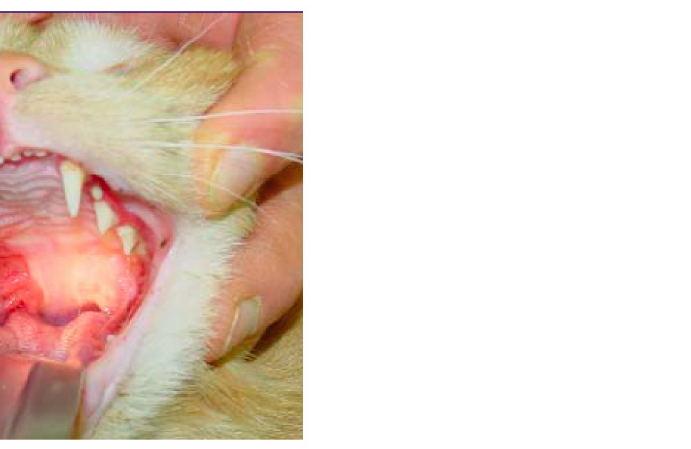
Figure 6. Feline chronic gingivostomatitis. ©University Animal Hospital Zurich, Felicitas